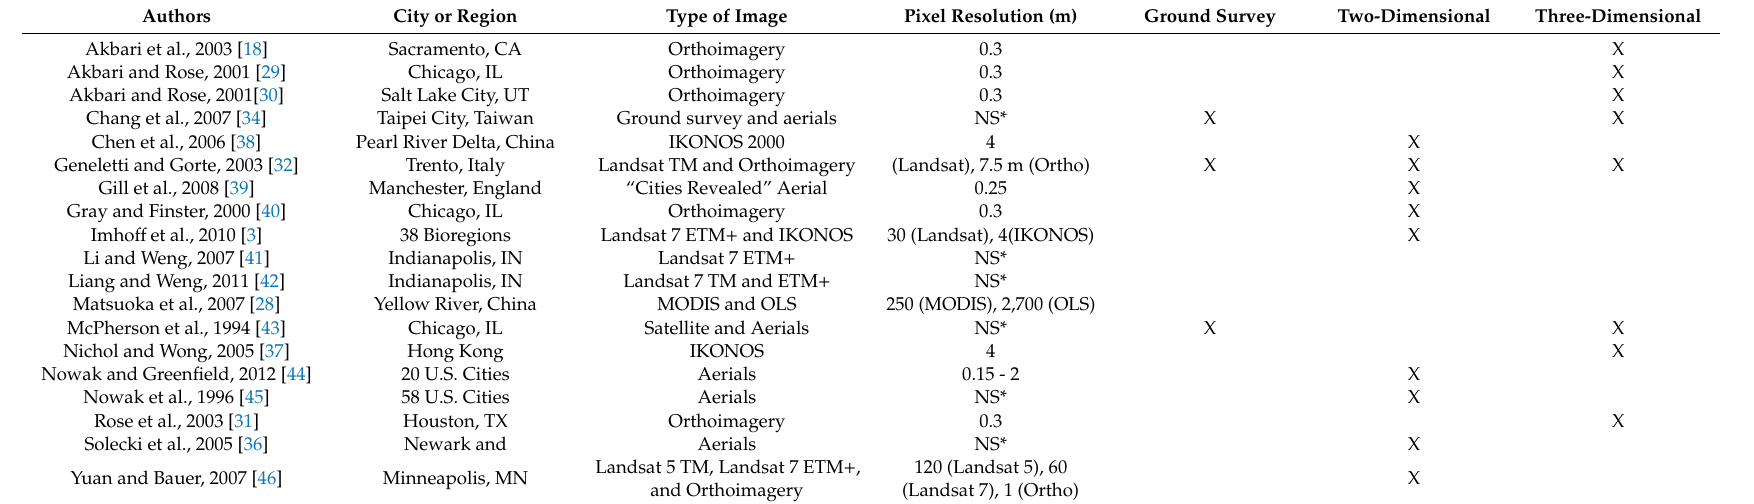
Table 2. Approach to quantifying land cover types by